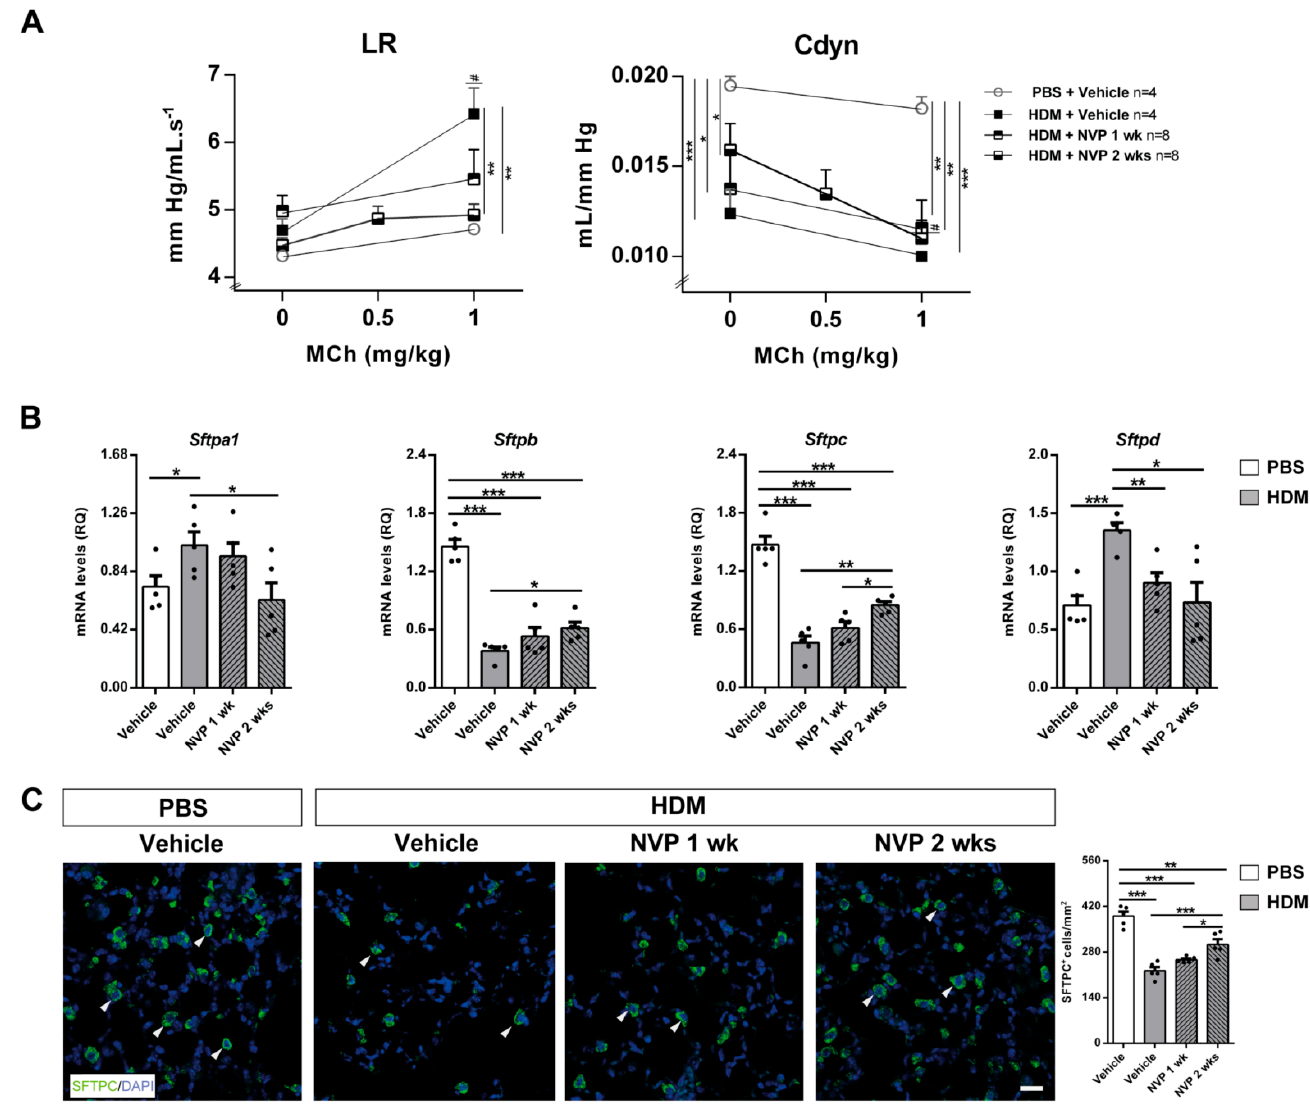
Figure 4. Therapeutic inhibition of IGF1R attenuates AHR and normalizes pulmonary surfactant expression upon HDM-induced allergy. ( A ) Quantification of lung resistance (LR) and dynamic compliance (Cdyn) to methacholine (MCh) evaluated by plethysmography ( n = 4–8 mice per group) and ( B ) changes in lung tissue mRNA expression surfactant ( Sftp ) markers Sftpa1 , b , c and d , normalized to 18S expression in HDM-challenged mice treated with NVP vs. controls ( n = 5 mice per group). ( C ) Representative immunostains for SFTPC (green) (white arrowheads), and quantification of the number of SFTPC + cells per unit area (mm 2 ) in lung sections from HDM-challenged mice treated with NVP vs. controls ( n = 5–10 mice per group; scale bar: 50 µm). Data are expressed as mean ± SEM. * p < 0.05; ** p < 0.01; *** p < 0.001; # p < 0.05 (comparisons within the same group) (Mann–Whitney U test or Student’s t -test for comparing two groups and Kruskal–Wallis test or ANOVA multiple comparison test for grouped or multivariate analysis).